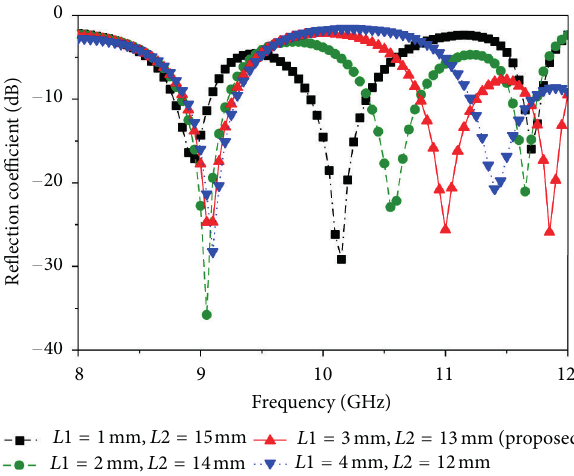
Figure 5: Simulated reflection coefficient for different values of 𝐿1 and 𝐿2 (other parameters: 𝐿 = 20 mm, 𝑊 = 17.2 mm, 𝐿 𝑠 = 9 mm, = 4 mm, 𝐿 = 20 mm, 𝑊 = 17.2 mm, 𝑅1 = 2 mm, 𝑅2 = 3 mm, 𝑊 𝑠 𝑔 𝑔 𝑌 = 10, 8.6 ). 𝑋 𝑓 , 𝑓